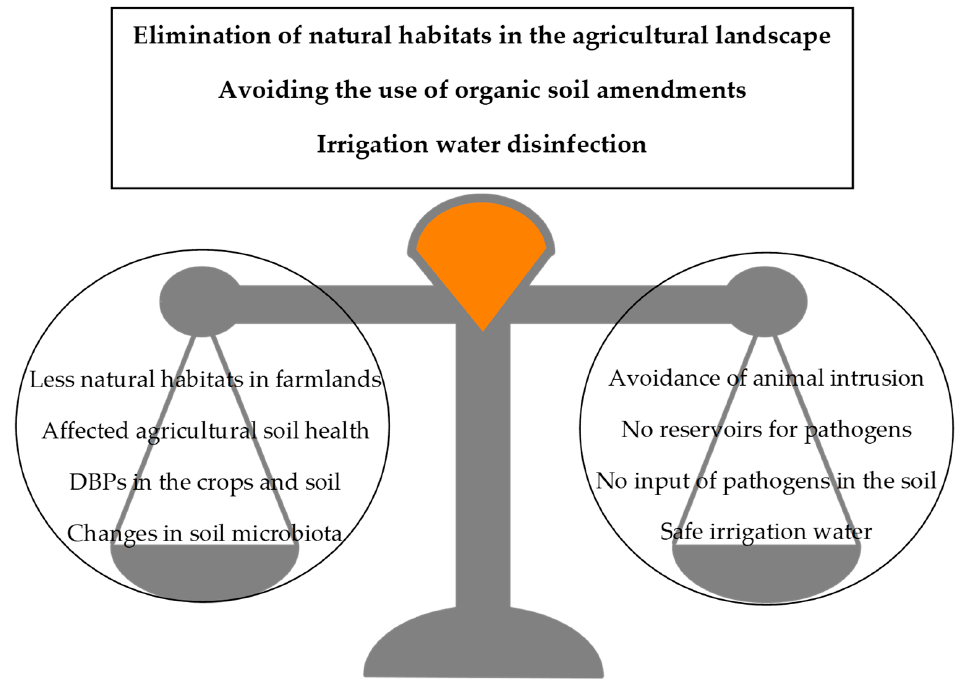
Figure 1. Potential environmental impacts (left) and fresh produce safety gains (right) of different measures applicable in primary production. DBPs: disinfection by-products.